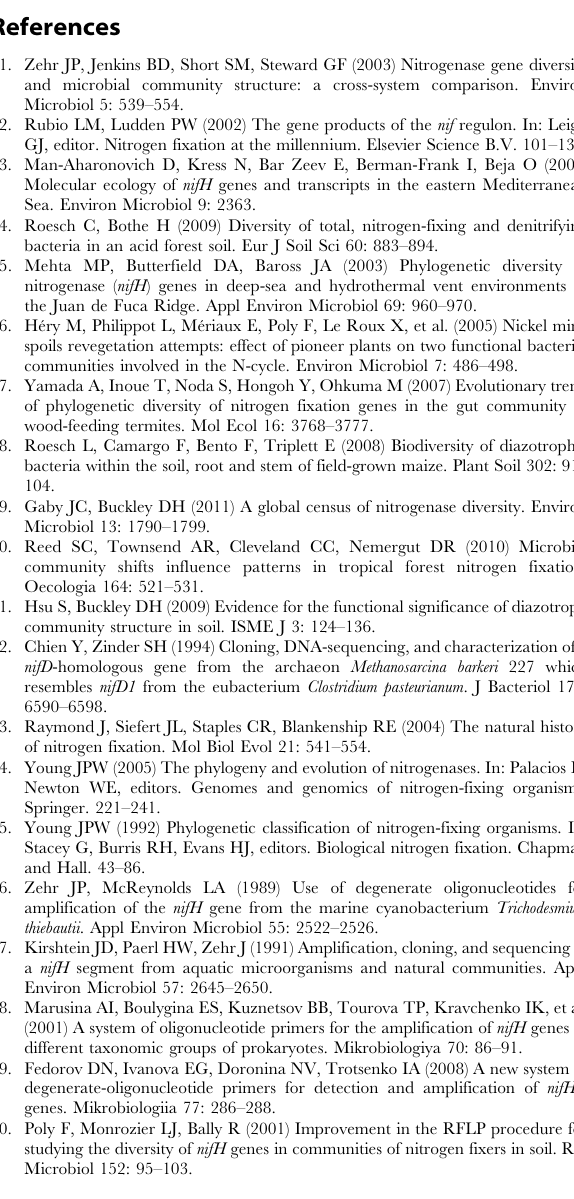
Figure S15 nifH3/nH21f primer pair at 41 6 C annealing temperature. Gel image of PCR products generated using the primers indicated with a range of different DNA templates. Results are summarized and full strain names are reported in Table 6. The gel images have been inverted from black to